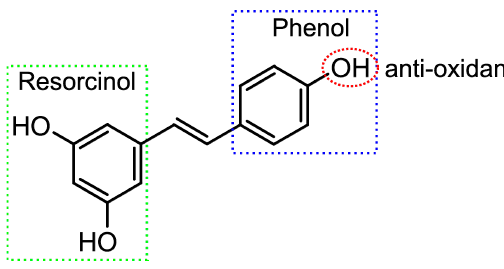
Figure 1. Molecular representation of the anti-oxidant capacity of resveratrol.